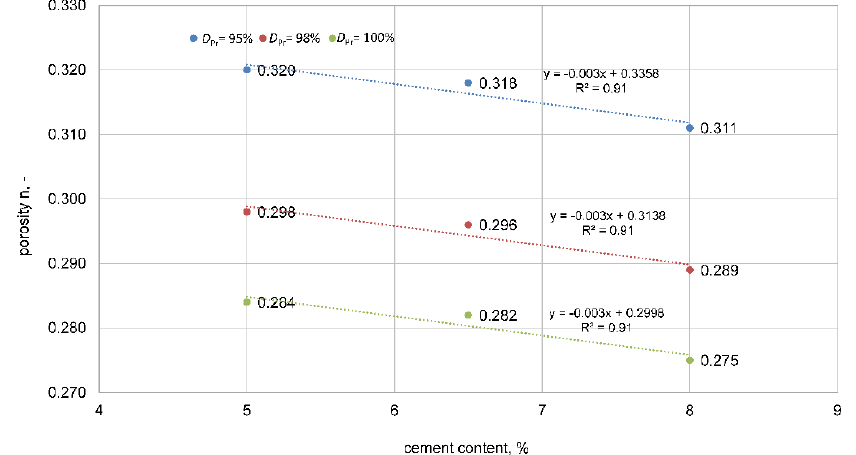
Figure 4. Influence of the addition of cement on porosity. — D Pr = 95%, — D Pr = 98%, — D Pr =